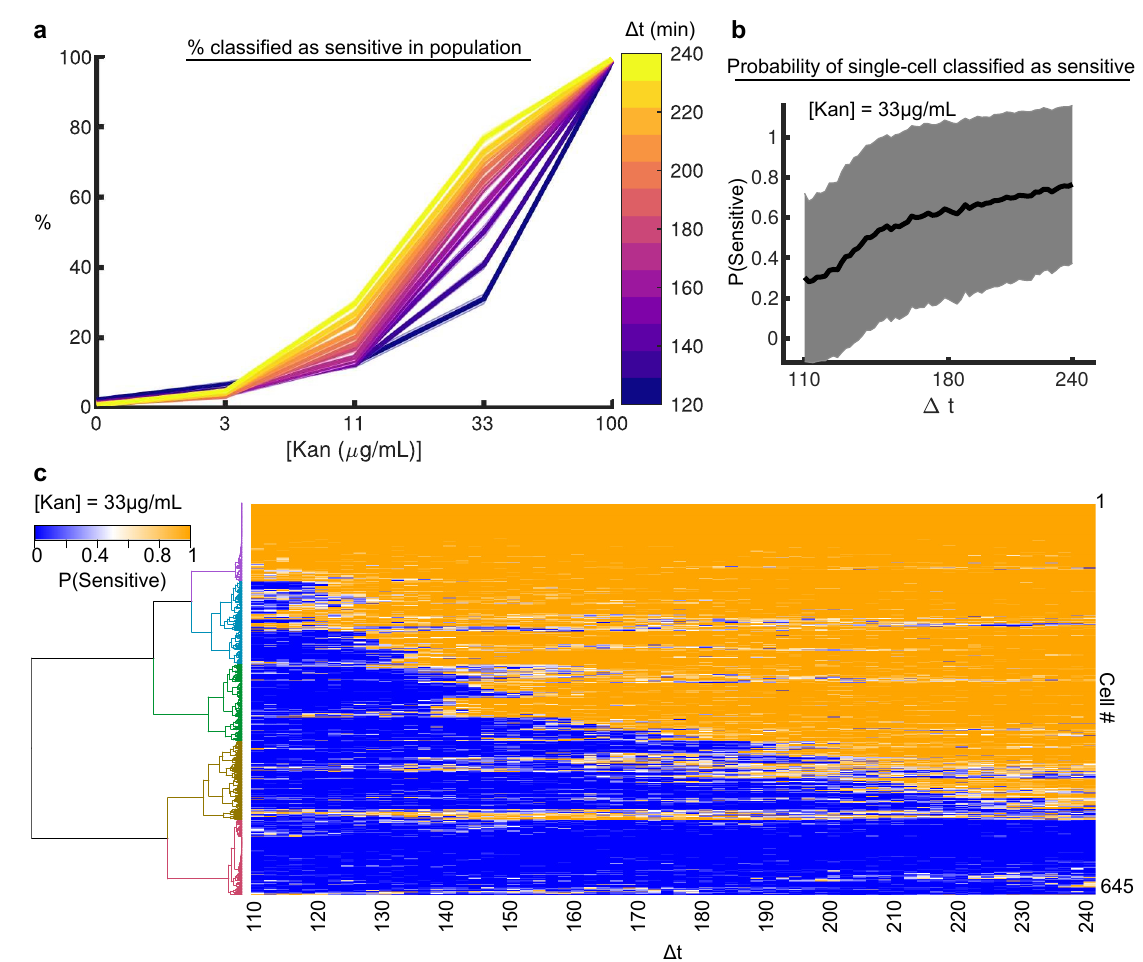
Figure 6. Machine learning-based single-cell pharmacokinetics and pharmacodynamics. ( a ) Percent of sensitive cells ( y -axis) classified by the random forest for each concentration of kanamycin ( x -axis) as a function of ∆ t (colorbar). Minimum ∆ t was 110 min corresponding to when the random-forest classifier’s error in classifying sensitive and resistant in the 100 µ g/mL kanamycin condition was < 5% (Figure 5b). As expected, the classifier correctly predicts ~0% of cells are sensitive at 0 µ g/mL kanamycin as all untreated cells look resistant. At the 100 µ g/mL kanamycin condition, ~100% are classified as sensitive. For the intermediate doses, as ∆ t increases (purple to yellow), the percent of cells classified as sensitive increases ( y -axis). Shaded error bar is the standard deviation in percentage between 10 classifiers. ( b ) The average probability of a single cell at the 33 µ g/mL concentration being classified as sensitive as a function of ∆ t . Shaded error bars denote the standard deviation in single-cell probability at every ∆ t . The large error bars are indicative of heterogeneity in single-cell predictions. ( c ) Heat map of a single-cells’ probability of being classified as sensitive (blue 0%, orange 100%) as a function of time ( ∆ t , x -axis) for the 33 µ g/mL kanamycin condition. The 645 cell probability traces are clustered (ward linkage)